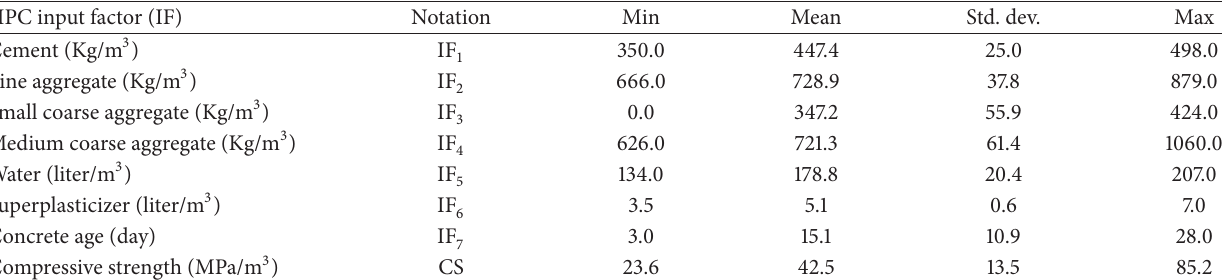
Table 1: Concrete components and statistical